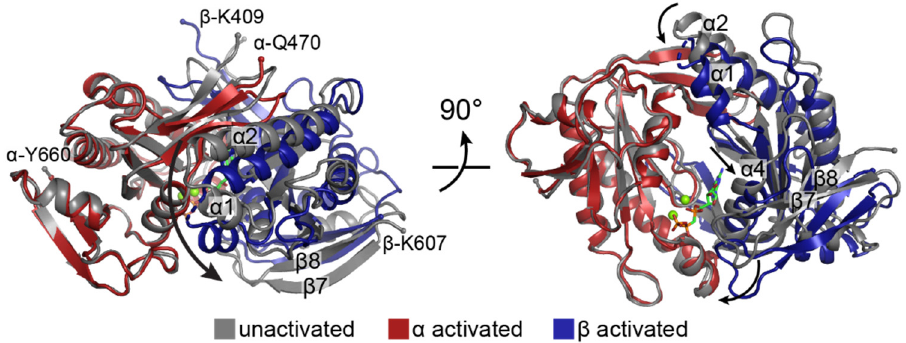
Figure 9. The sGC CAT domains undergo a conformational change upon activation. Superposition of the unactivated (grey, PDB ID 6JT0 [65]) and activated (colored as in Figure 4, PDB ID 6JT2 [65]) sGC CAT domains. Clamping of the β subunit relative to the α subunit is achieved through motions of the β 7– β 8 loop and the α 1 and α 2 helices, as indicated by the curved black arrows. Shifting of the α 4 helix opens the active site for substrate binding, as indicated by the straight black arrow. The substrate analog GMPCPP of the activated structure is shown as sticks with C in green, N in blue, O in red, and P in orange. The two magnesium ions are shown as green spheres. Structures were aligned by least squares fitting of the α subunits (r.m.s.d. = 1.13 Å for 189 C α atoms). The N- and C-terminal residues of each domain are labeled and shown as small spheres.